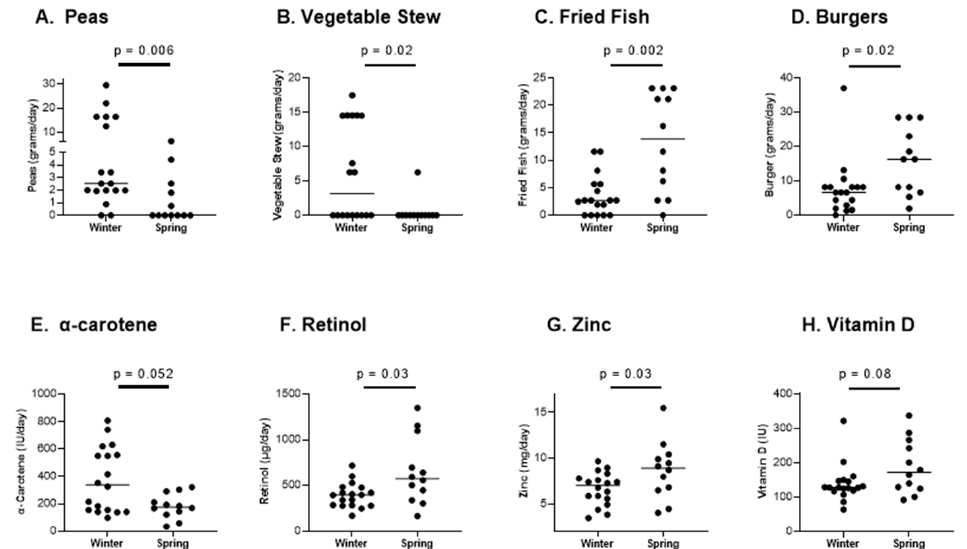
Figure 3. Dietary intake changes with season. Parents/guardians of 30 children completed an FFQ. FFQ results reported in the winter (December (2016), January (2017), and February (2017)) were compared to results reported in the spring (March to May 2017). A portion of variables are shown, including ( A – D ) food items, and ( E – H ) calculated intakes of vitamins and zinc. Each symbol represents a different child with medians shown. There were seven foods (from approximately 90 tested food groups) that were significantly different between winter and spring, as revealed both by t -tests and Mann–Whitney tests. These were peas, vegetable stews, peanut butter, butter, and pretzels (more prevalent in the winter), and fried fish and burgers (more prevalent in the spring). Results of Mann–Whitney tests are shown. Significant differences between black and white participants were not observed for these